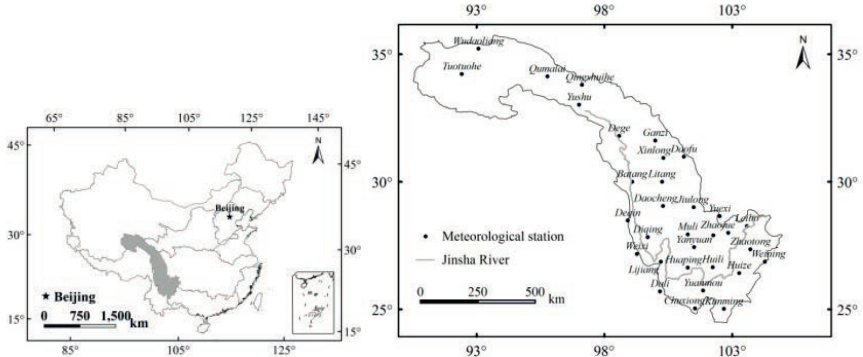
Fig. 1 Location of Jinsha River basin and the meteorological